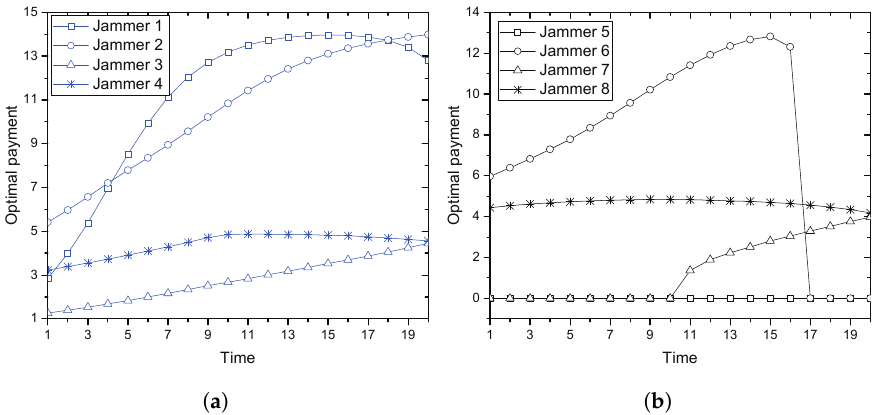
Figure 6. Comparison of payment to Alice from different jammers: ( a ) jammers from J C ; ( b ) jammers from J N